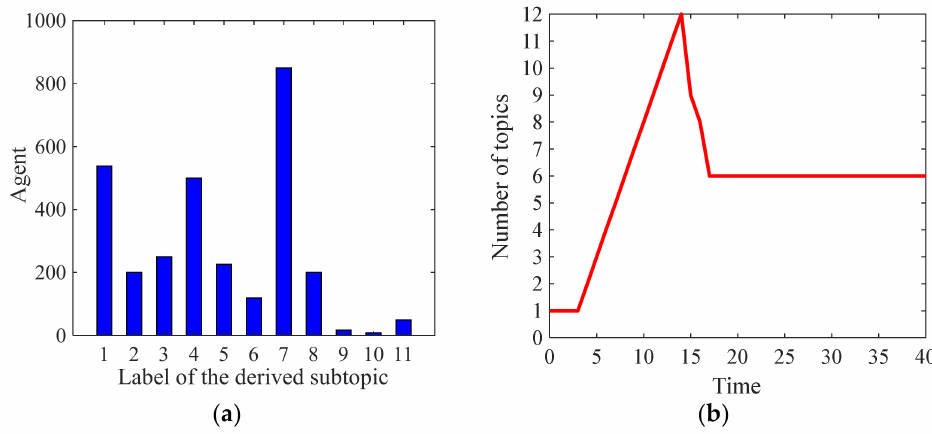
Figure 33. Simulation of derived subtopics for this public opinion used the model proposed in this paper. ( a ) The number of agents discussing derived subtopics. ( b ) Change in the number of